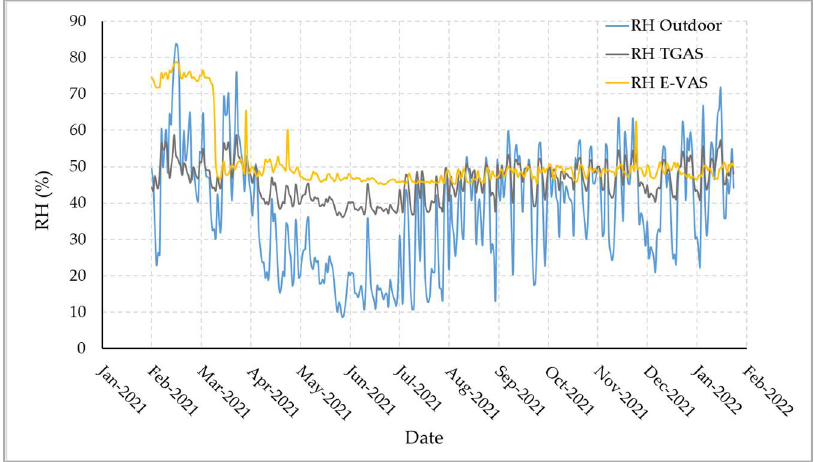
Figure 9. Average temperatures of the outdoor (T Outdoor), the indoor (T Indoor), the traditional greenhouse acclimatization system (TGAS), and the designed ex vitro acclimatization system (E-VAS).